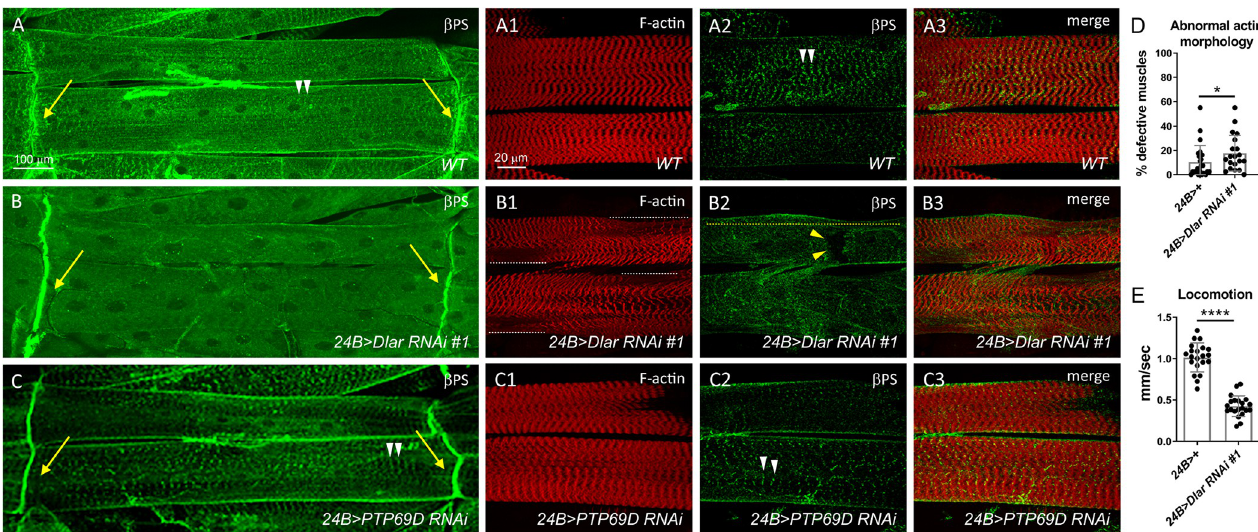
Fig 3. Dlar is required for the localization β PS integrin at costameres. Low (A-C) or high (A1-A3, B1-B3, C1-C3) magnification images of ventral longitudinal muscles in the L3 stage. Anterior is left in all images. WT (A), 24B > Dlar RNAi #1 (B), and 24B > PTP69D RNAi (C) larvae display characteristic β PS localization by immunofluorescence at the MTJ (yellow arrows). F-actin patterning and Z-disc co-localization of β PS appears normal in WT (A-A3) and PTP69D RNAi muscles (C-C3). (B-B3) Induction of Dlar RNAi results in a loss of sarcomeric patterning (white dotted line) and a general loss of β PS distribution at Z-disc sites across muscle (yellow dotted line). Disruption of the sarcolemmal integrity was also more pronounced in Dlar RNAi muscles (B2, yellow arrowheads). (D) Bar and scatter plot depicts that the percentage of defective muscles assayed by F-actin staining is increased upon induction of Dlar RNAi in muscle tissue. Mean +/- SD. � , p < 0.05. N � 20. (E) Locomotion assay shows that a reduction in Dlar compromises movement of L3 larvae as depicted in the bar and scatter plot. Mean +/- SD. ���� , p < 0.001. N � 20.